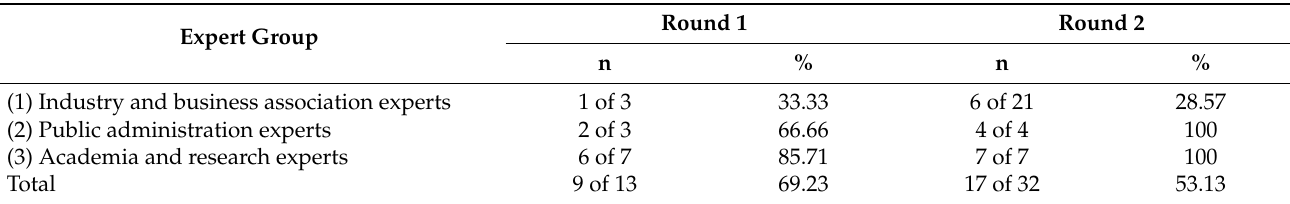
Table 2. Response rates of expert